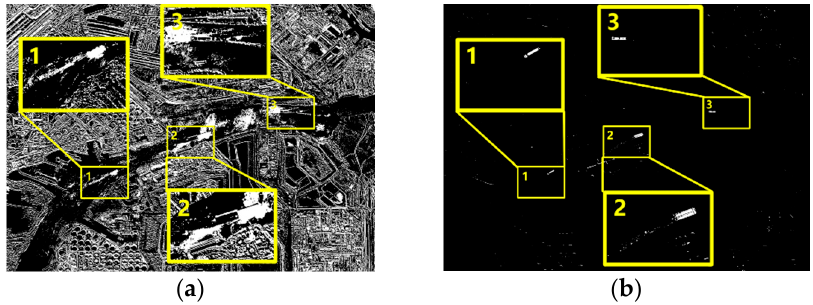
Figure 7. Inter-frame difference results : ( a ) the first difference; ( b ) the second difference.